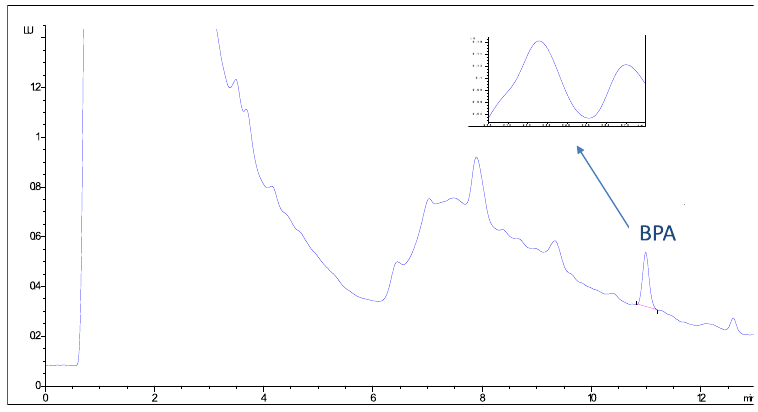
Figure 2 . HPLC-FLD chromatogram of a blank sample ( “ sweet corn ” ) with a fortification level of 0.01 Figure 2. HPLC-FLD chromatogram of a blank sample (“sweet corn”) with a fortification level of mg kg −1 . Luminescence unit (LU) vs Retention Time (min). 0.01 mg kg − 1 . Luminescence unit (LU) vs Retention Time